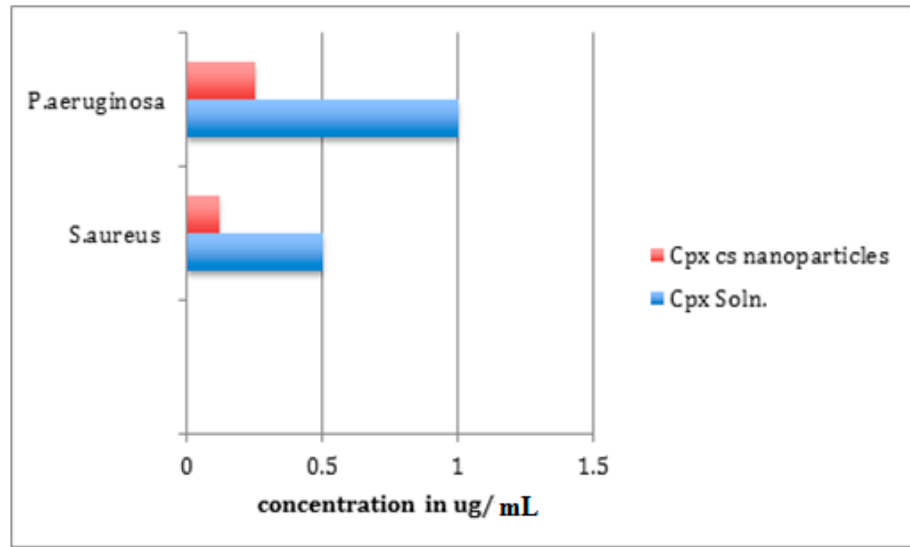
Figure 9. Antibacterial activity of CHCl soln. and CHCl-loaded CS-NPs.